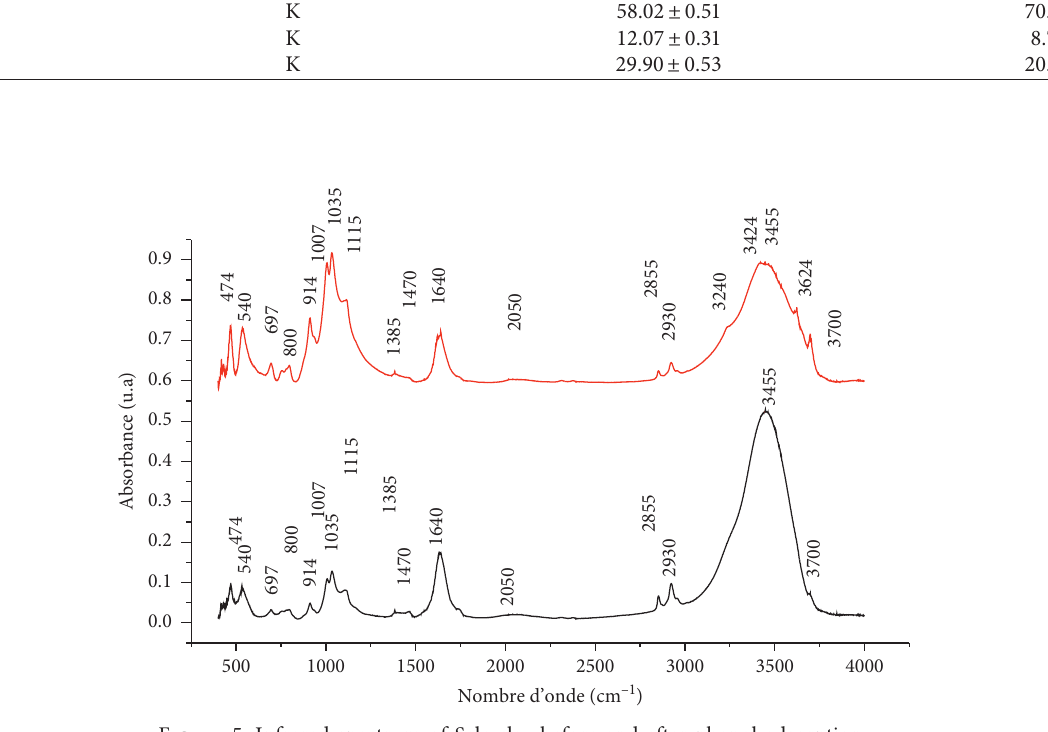
Figure 5: Infrared spectrum of Sale clay before and after phenol